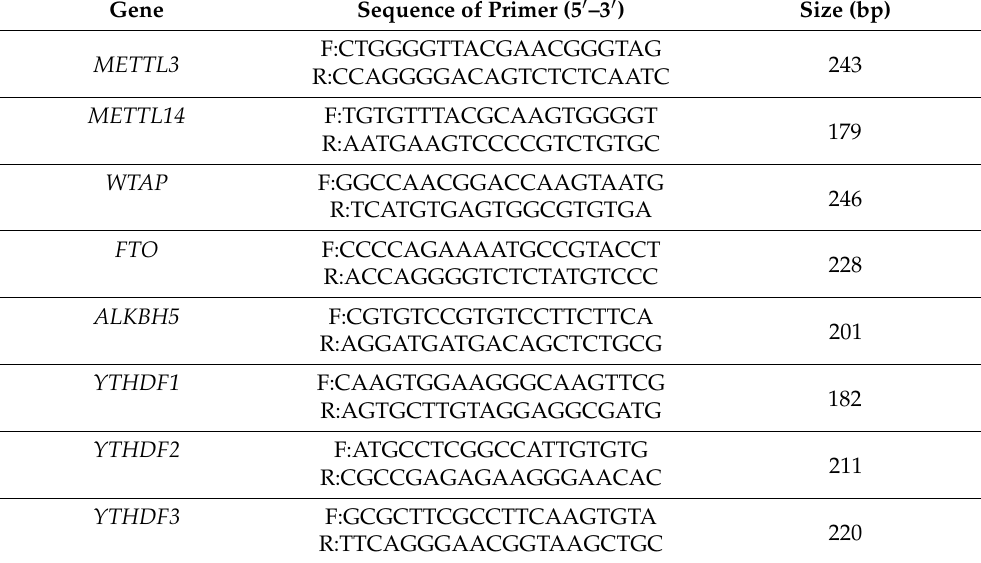
Table 1. Primer sequences used for quantitative real-time polymerase chain reaction (qPCR).